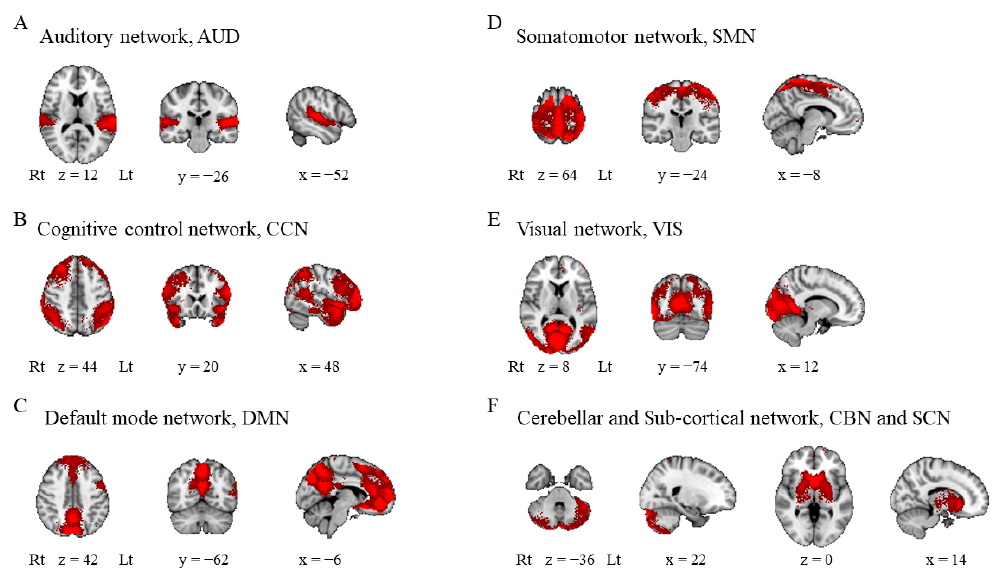
Figure 1. Intrinsic connectivity networks. Independent components were classified into seven networks: ( A ) auditory network, ( B ) cognitive control network, ( C ) default mode network, ( D ) somatomotor network, ( E ) visual network, and ( F ) cerebellar and subcortical networks. Lt, left; Rt, right.